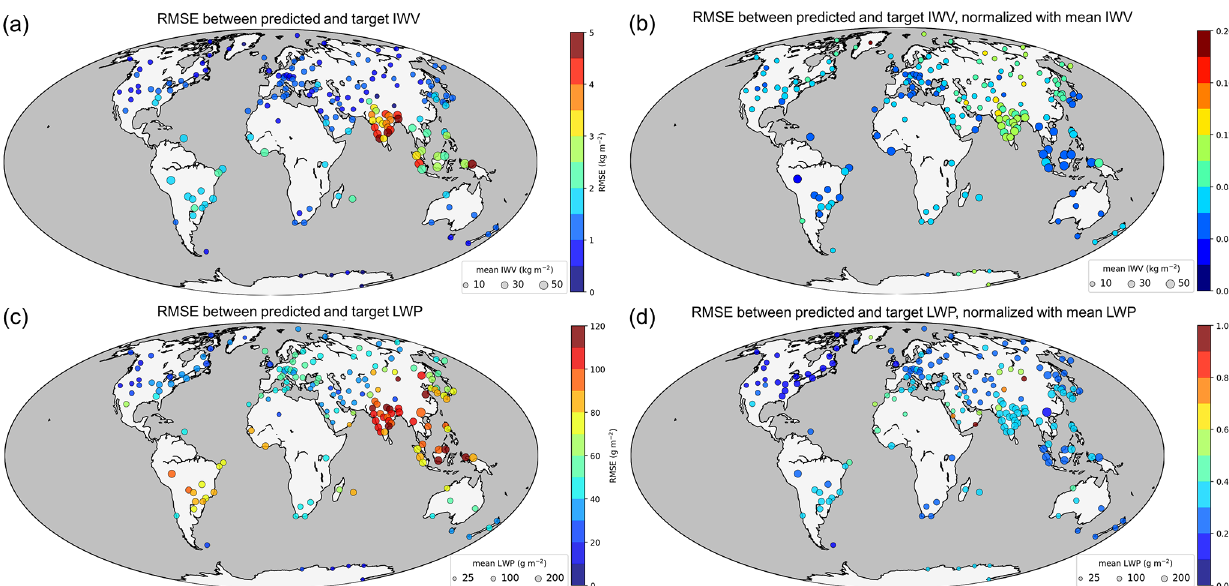
Figure 8. Geographical distribution of the error for the synthetic dataset. Panels (a) and (c) illustrate the total RMSE for IWV and LWP, respectively. Panels (b) and (d) show the normalized error, i.e., the RMSE normalized by the mean value of IWV (LWP) at each location. For the evaluation of LWP, clear-sky and strong rainy cases are removed (LWP < 20gm − 2 and LWP > 1000gm − 2 ). The size of the disks represents the mean value of IWV or LWP at each site, while the color codes are for the error of the